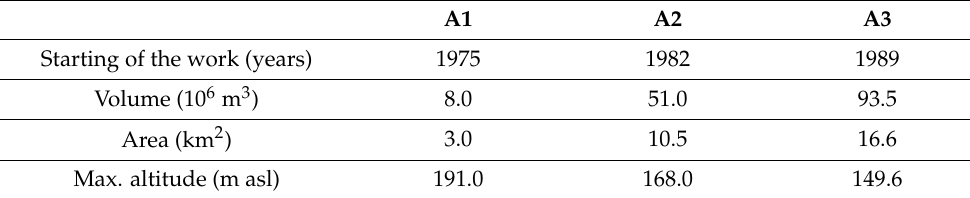
Table 2. Basic characteristics of reservoirs on the Drava are shown in Figure